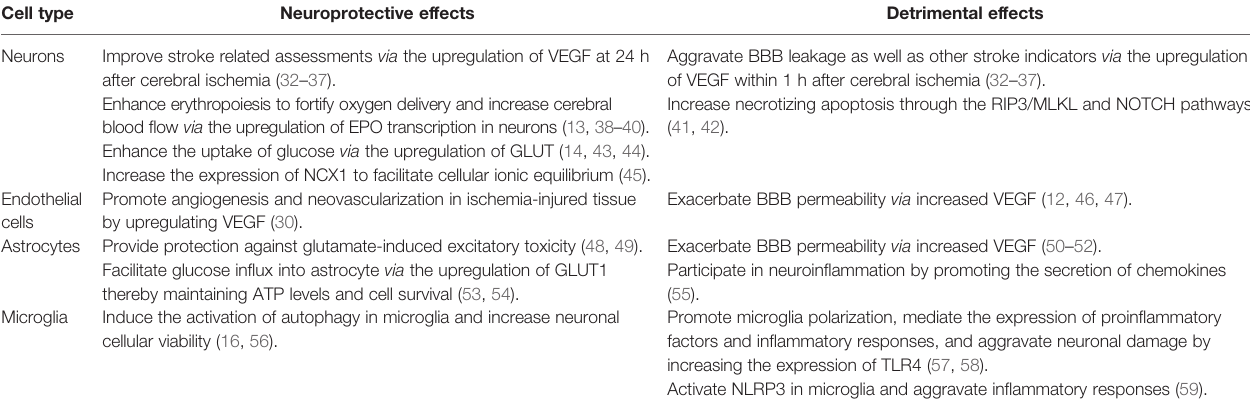
TABLE 1 | Bidirectional roles of HIF-1 a in different cells.